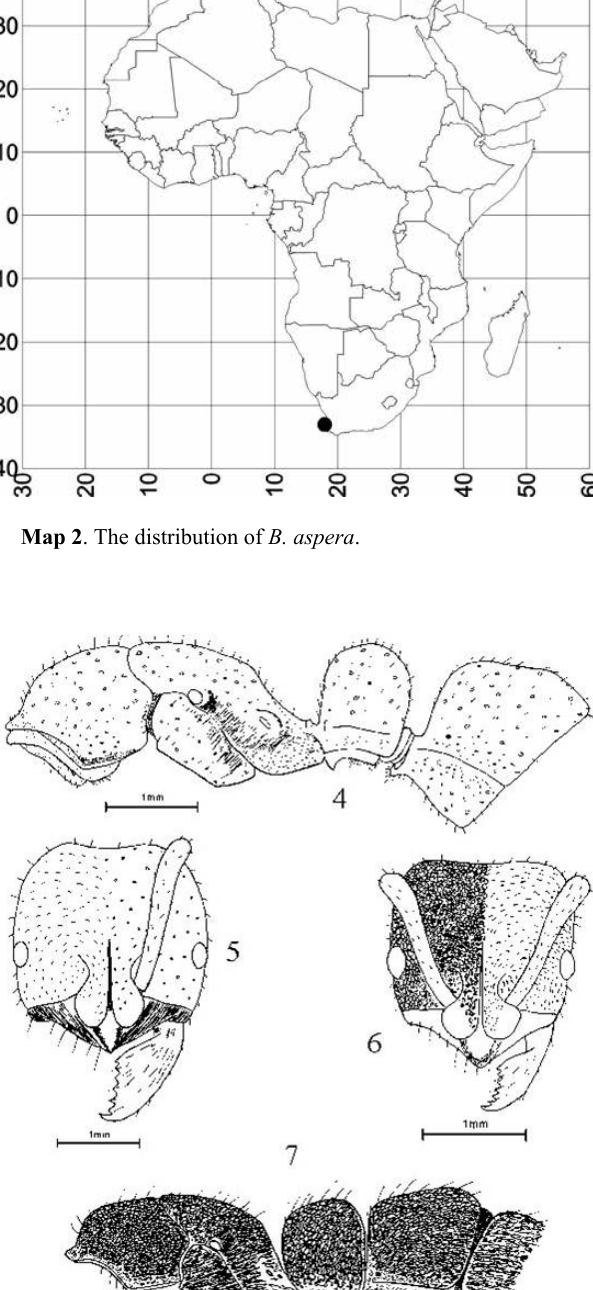
The sculpturing of the head is shown only on the right or left side, to allow the illustration of the hairs on the other side of the head.